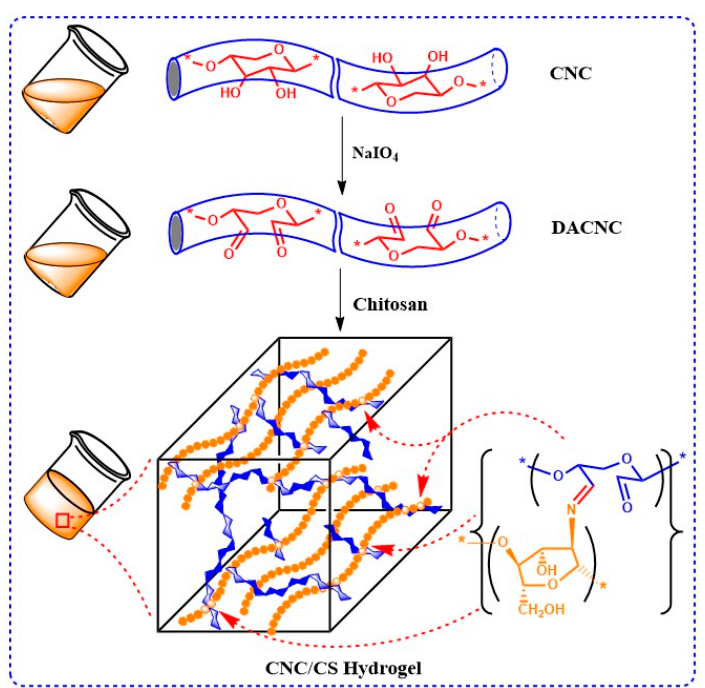
Table 1. Elemental analysis of cellulose nanocrystal/chitosan (CNC/CS) hydrogels.